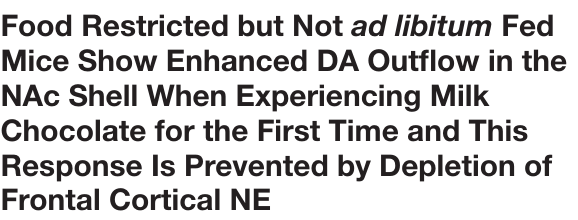
of FR but not FF mice. It is worth pointing out the discrepancy between present and previous results obtained in rats (Bassareo and Di Chiara, 1999), that can be easily explained by species difference as well as by differences in the type of milk chocolate used (white chocolate in the previous study: see Ventura et al., 2008 for